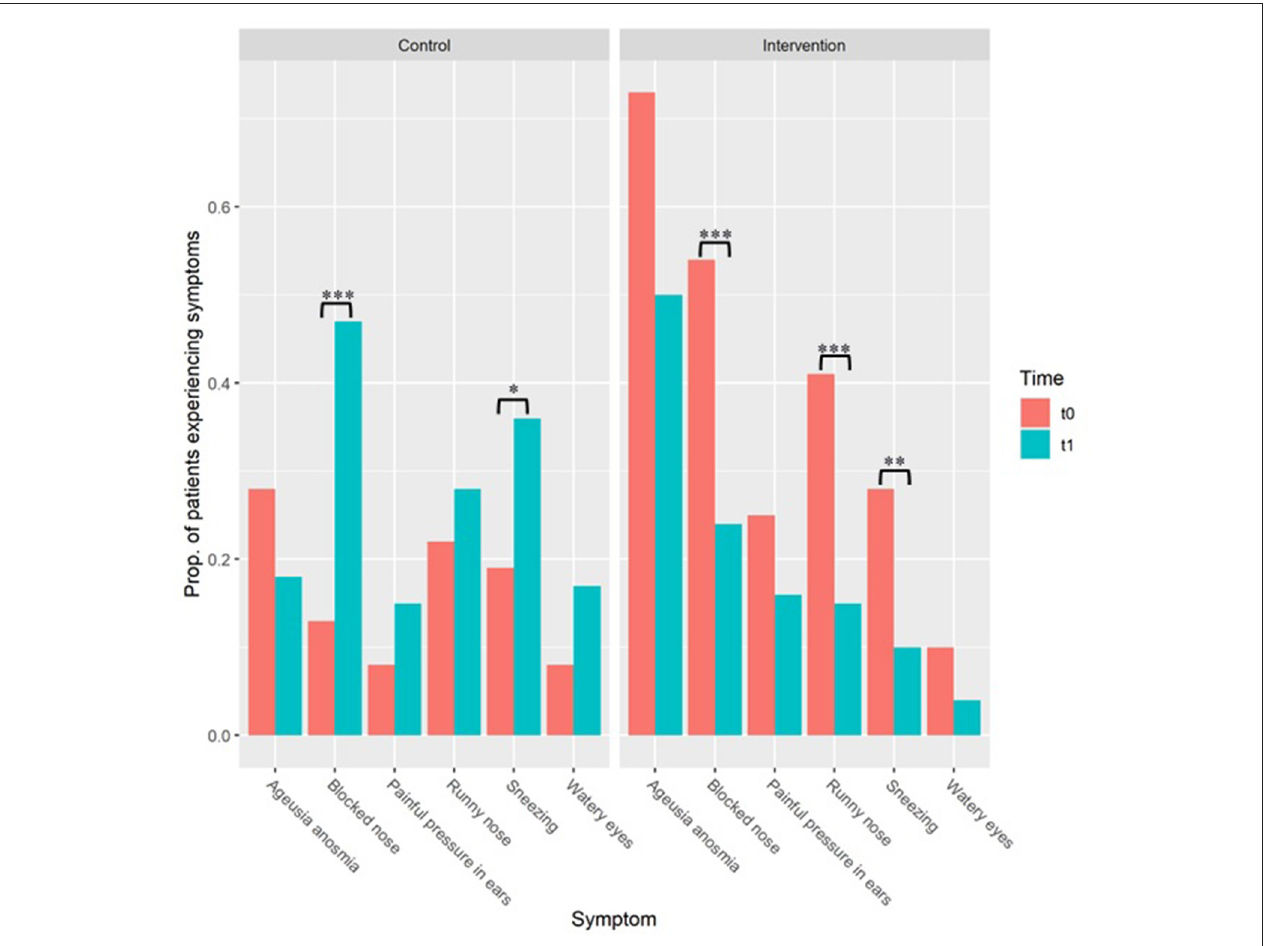
FIGURE 1 | Proportion (“Prop.” within the figure) of patients reporting otolaryngologic COVID-19 symptoms. “t0” refers to baseline. “t1” refers to follow-up period after 10 days. Results of the control group are reported on the left (“Control”) and those of the treatment group are reported on the right (“Treatment”). Note. * p ≤ 0.05, ** p ≤ 0.01, *** p ≤